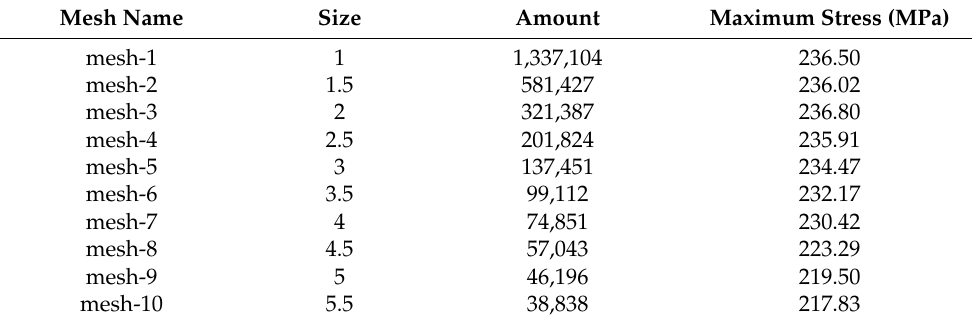
Table 6. Calculation results for different